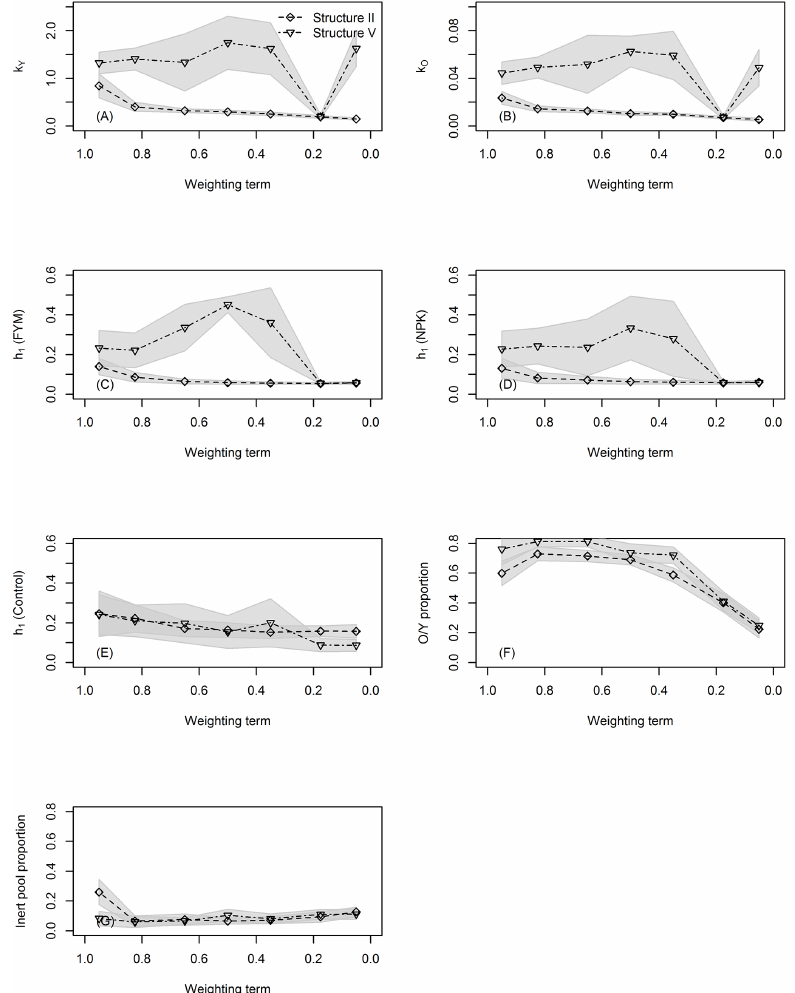
Figure 5. Effect of the SO 14 C data over the main SOC parameters in structure II and V. In this scale 1 means only total C, 0 means only SO 14 C. Letters A to G denote subpanels referring to different parameters. The shaded areas represent the error of the calibrated parameter (calculated as standard deviation of the whole Markov